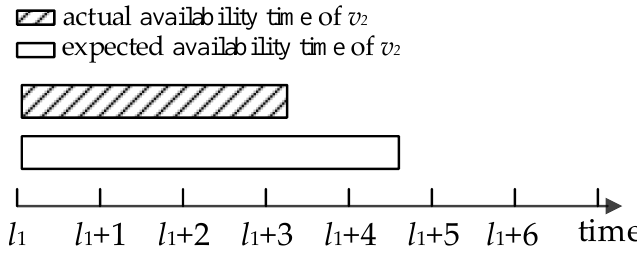
Figure 4. The expected availability time and the actual availability time of the node v 2